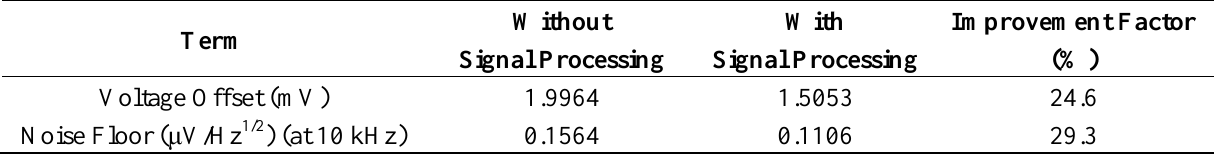
Table 4. Simulated demonstration of performance improvement with signal processing. Without With Improvement Factor Term Signal Processing Signal Processing (%) Voltage Offset (mV) 1.9964 1.5053 24.6 Noise Floor (μV/Hz 1/2 ) (at 10 kHz) 0.1564 0.1106 29.3